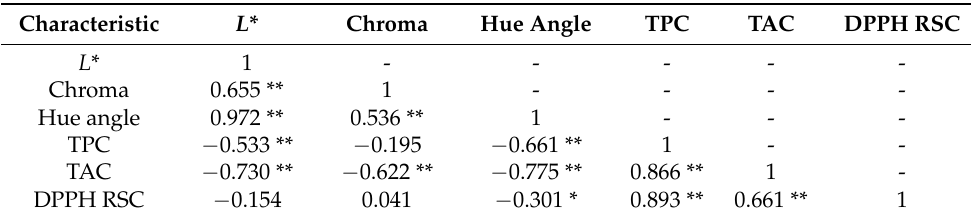
Table 9. Correlations between skin color characteristics ( L *, Chroma, Hue angle), TPC, TAC, and DPPH